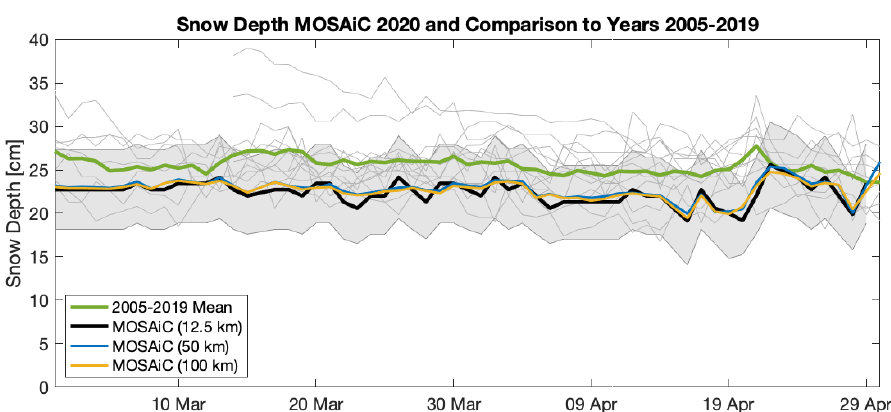
Figure 14. Snow depth from the AMSR-E and AMSR2 satellite microwave radiometers from 1 March to 30 April of the years 2005 to 2020 (without 2012) at the MOSAiC location. For the MOSAiC year 2020, the thick black line shows snow depth at 12.5km radius. The gray shaded area indicates the corresponding uncertainty bounds (Rostosky et al., 2018, 2020). The blue and yellow line gives the mean snow depth at a 50 and 100km radius for comparison. The thin gray lines show the individual years (2005 to 2019), and the green line provides the climatological mean. Because the MOSAiC floe was located in an area with partly second-year ice, snow depth can only be retrieved for March and April (Rostosky et al.,